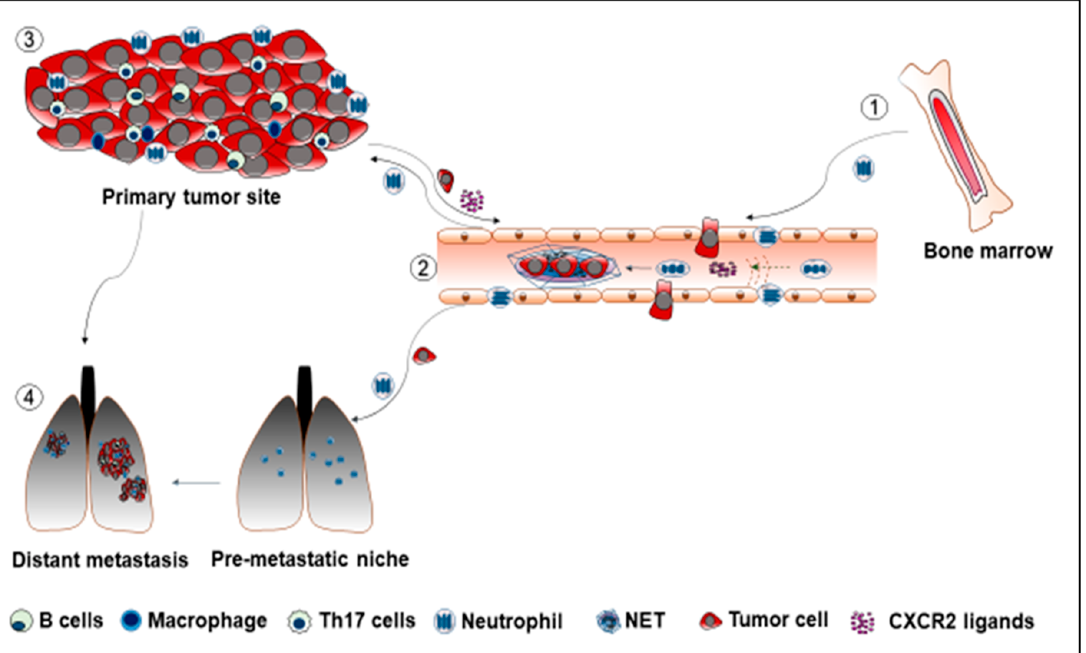
Figure 1. ① Neutrophils mobilize from bone marrow, enter the circulatory system, and move using a Figure 1. 1 (cid:79) Neutrophils mobilize from bone marrow, enter the circulatory system, and move